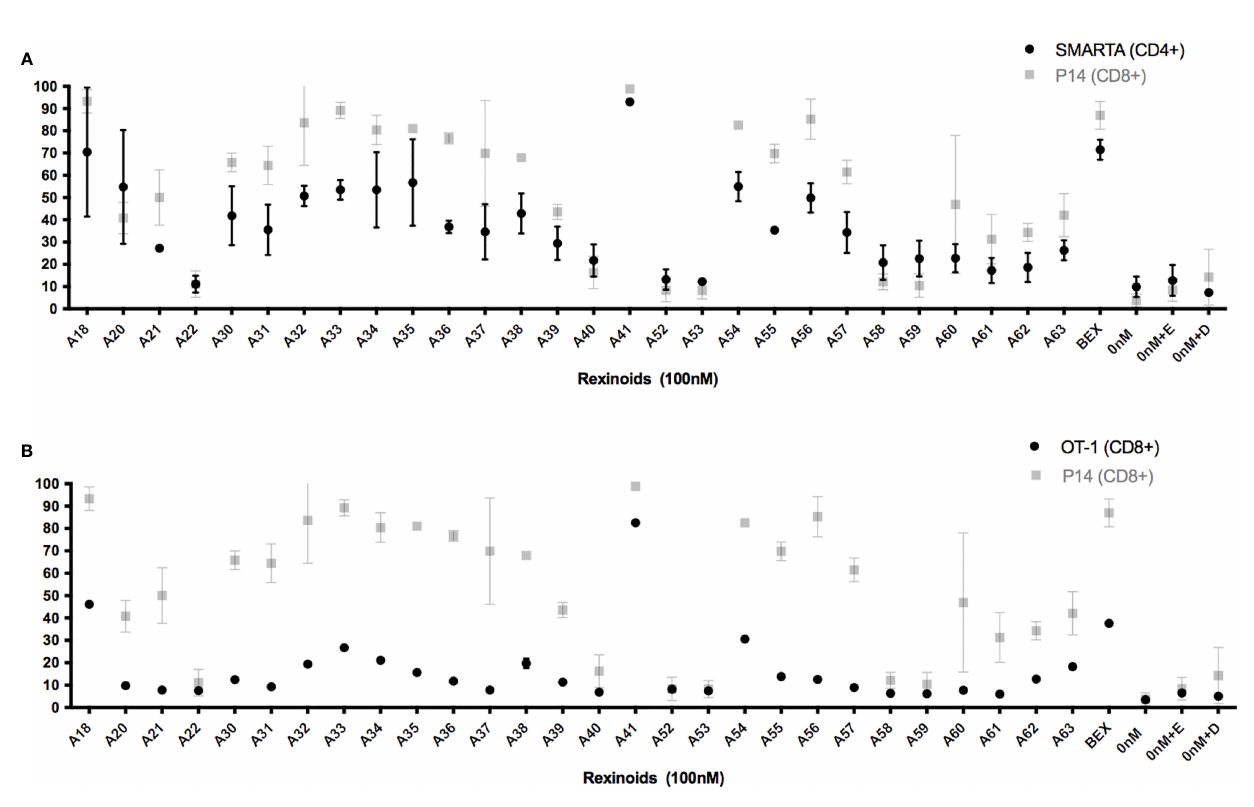
FIGURE 3 | Rexinoid treatment enhances CCR9 expression on effector T cells of different antigen speci fi city in vitro . Splenocytes obtained from naïve SMARTA and OT-1 mice were stimulated with GP 61-80 peptide and OVA 257-264 , respectively, and cultured for 8 days with the same panel of novel rexinoids delivered at a 100nM concentration (treatment every 48 hours). Cells were then analyzed for changes in expression of CCR9. Analysis was performed using fl ow cytometry. (A) CCR9 expression on antigen-speci fi c effector CD4+ T cells from SMARTA mice following rexinoid treatment (black circles) superimposed onto results from Figure 2C (gray squares). SMARTA experiment performed in duplicate. (B) CCR9 expression on antigen-speci fi c effector CD8+ T cells from OT-1 mice following rexinoid treatment (black circles) superimposed onto results from Figure 2C (gray squares). OT-1 experiment performed in duplicate. All error bars represent SD from the